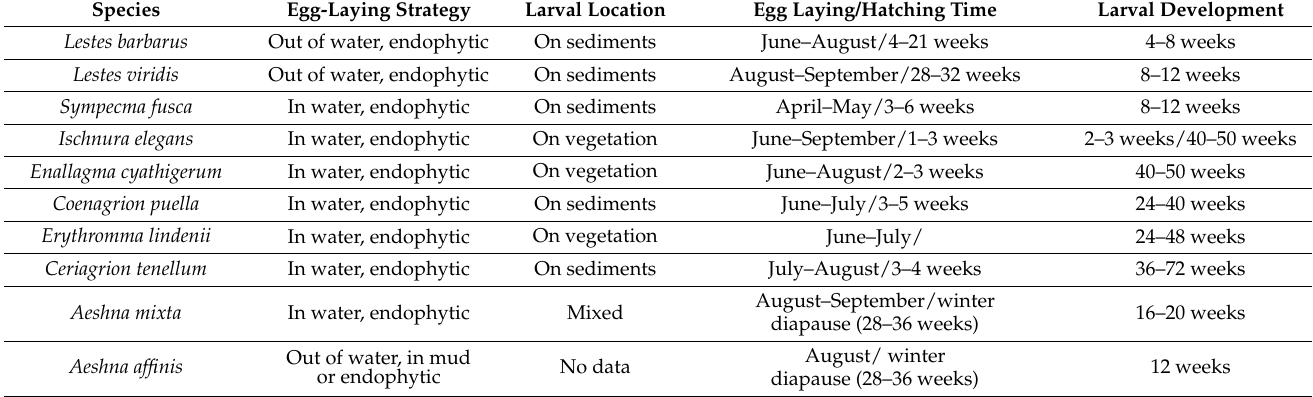
Table 2. Egg-laying strategy, larval location, egg-laying time, egg hatching time and larval develop- ment time of the 18 lentic species observed in Mond é ly. Mixed larval location means that larvae occur both on sediments and on vegetation. Data from references [7,8].